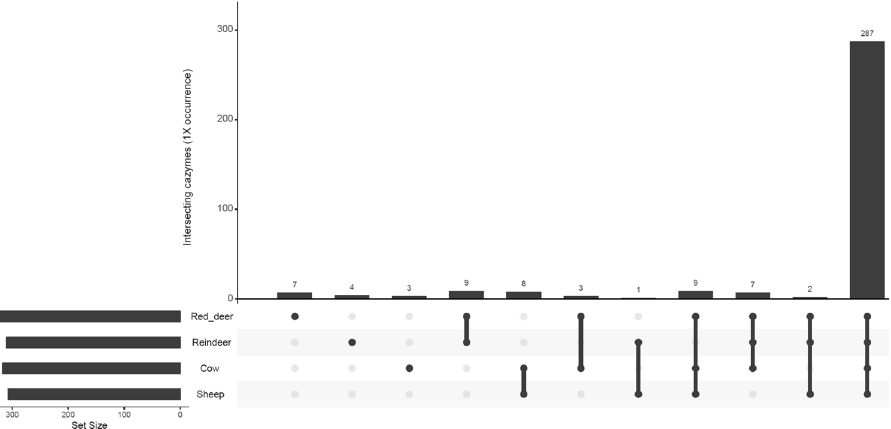
Figure 6. UpSetR graph showing the number of shared CAZyme families at average ×1 coverage within four ruminant species.